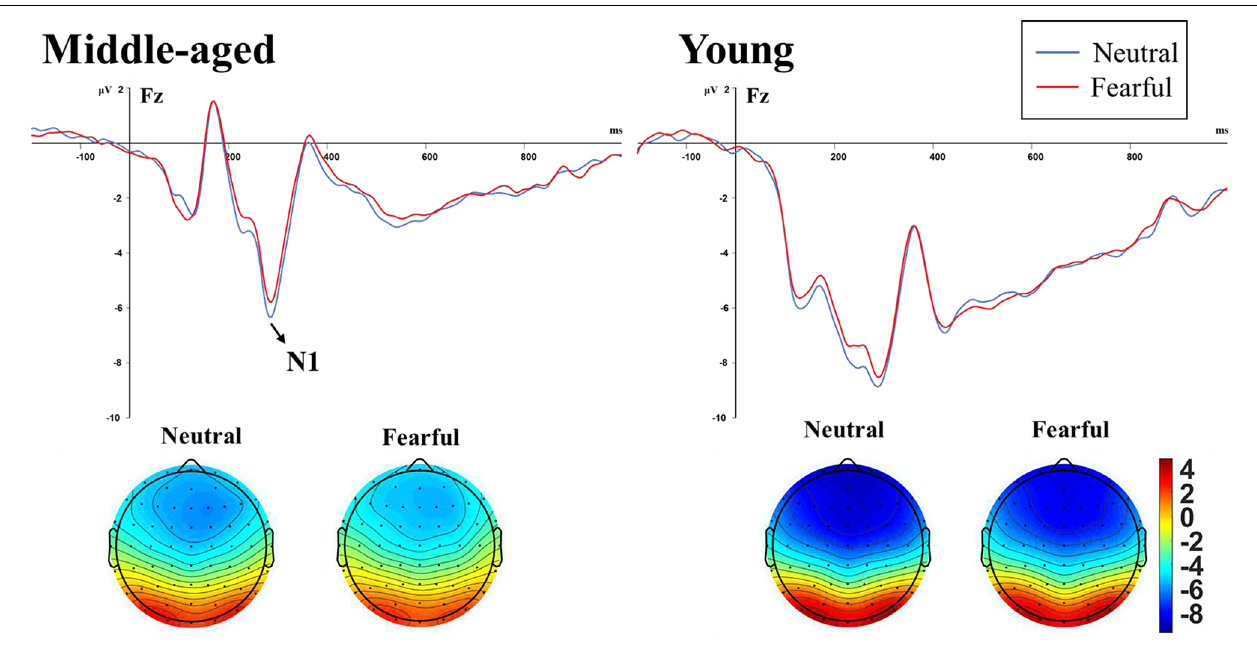
FIGURE 3 | N1 waveform and topographic maps elicited by auditory standard stimuli under neutral and and fearful facial expressions in the middle-aged adults group (left) and young adults group (right). The amplitude was significantly modulated by Age and Emotion independently.